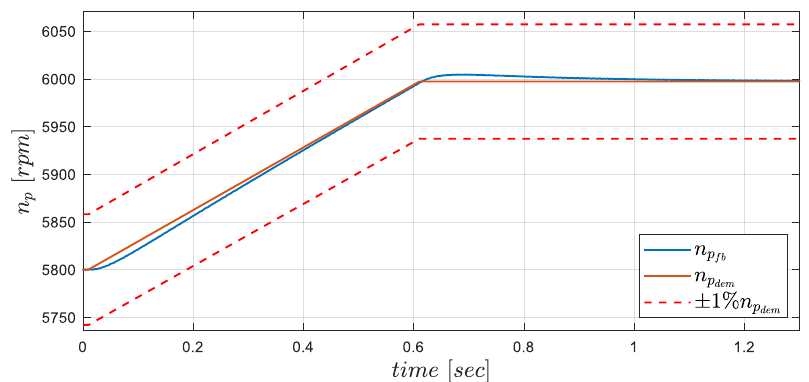
Figure 10. Propeller speed tracking in normal conditions.